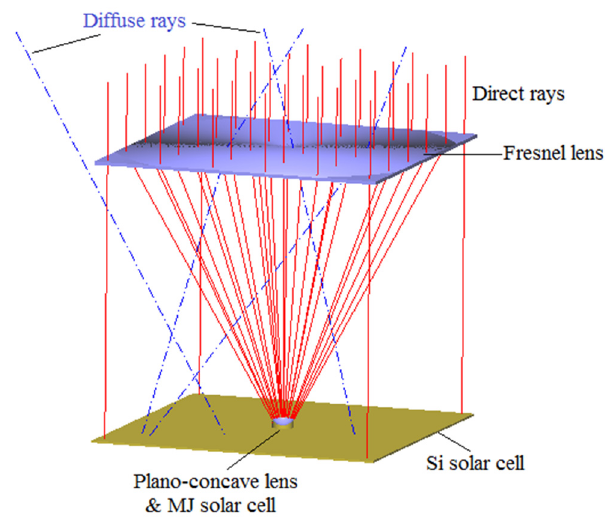
Figure 5. Ray ‐ tracing of the designed CPV unit with the SOE and Si solar cell. Figure 5. Ray-tracing of the designed CPV unit with the SOE and Si solar